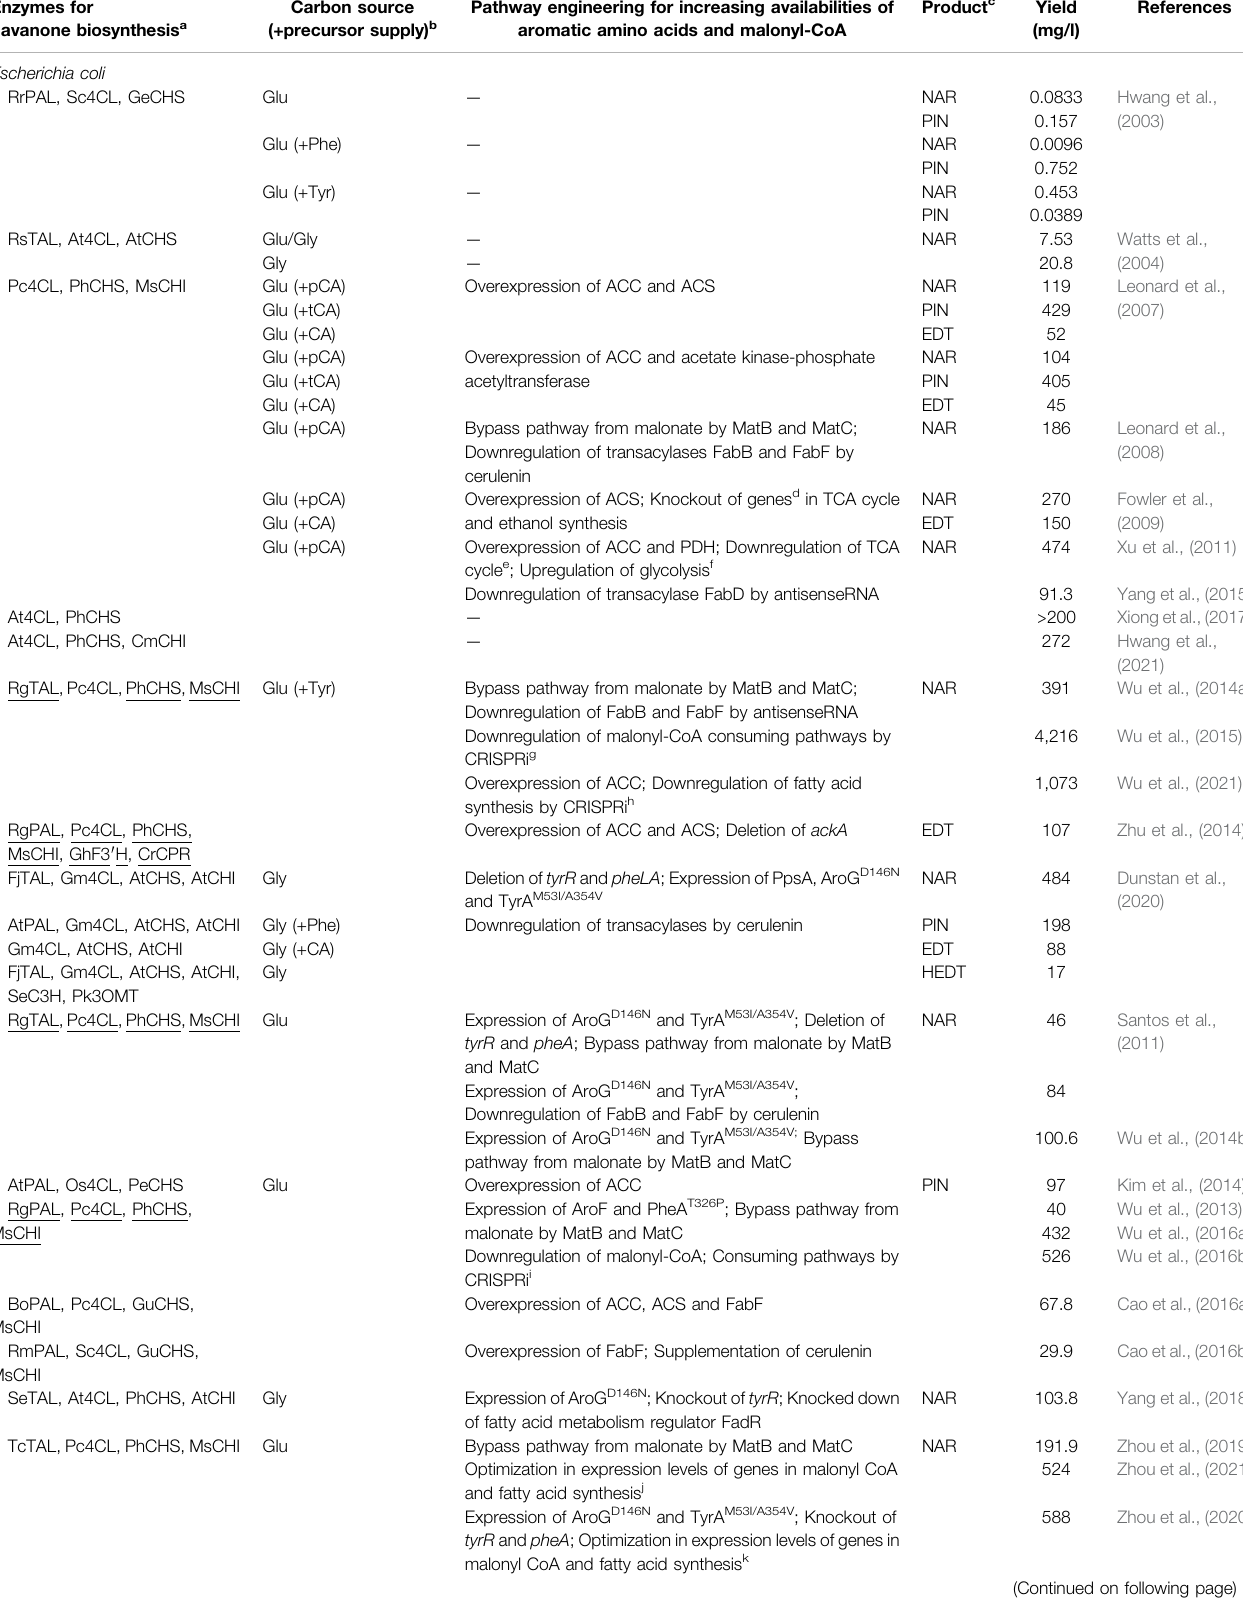
TABLE 1 | Flavanones production using different microbes. Enzymes for fl avanone biosynthesis